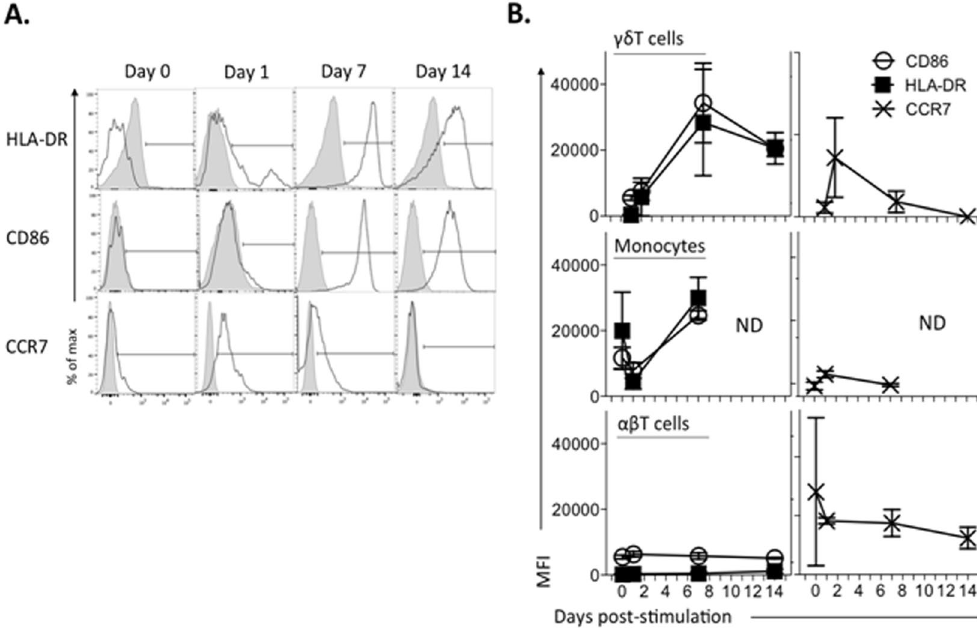
Figure 4. γδ T cell acquisition of phagocytic capacity is concurrent with sustained upregulation of cell surface HLA-DR and CD86, but not CCR7. Freshly-isolated PBMC (n = 5) were expanded for 14 days with irradiated E. coli , and stained for cell surface HLA-DR, CD86 and CCR7 throughout expansion. ( A ) Representative stains of one donor γδ T cells is shown, with specific antibody in black, unshaded, and isotype-matched control - in gray, shaded. ( B ) HLA-DR, CD86 (left column) and CCR7 (right column) MFI over expansion was compared between γδ T, αβ T cells and monocytes (CD3 neg CD14 pos